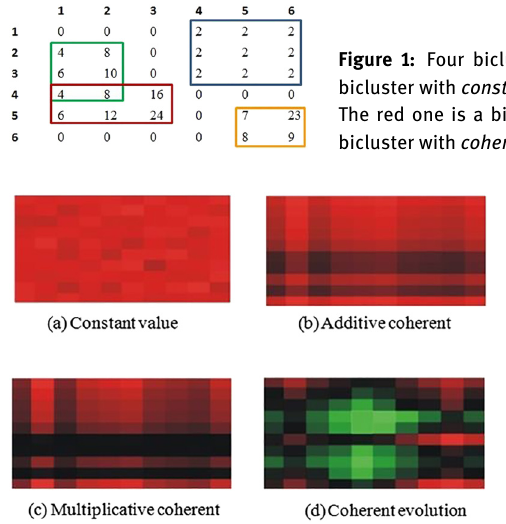
Figure2: Differenttypesofbiclustersshownasheatmaps,wherethe red color encodes high expression levels and the green one encodes low expression levels